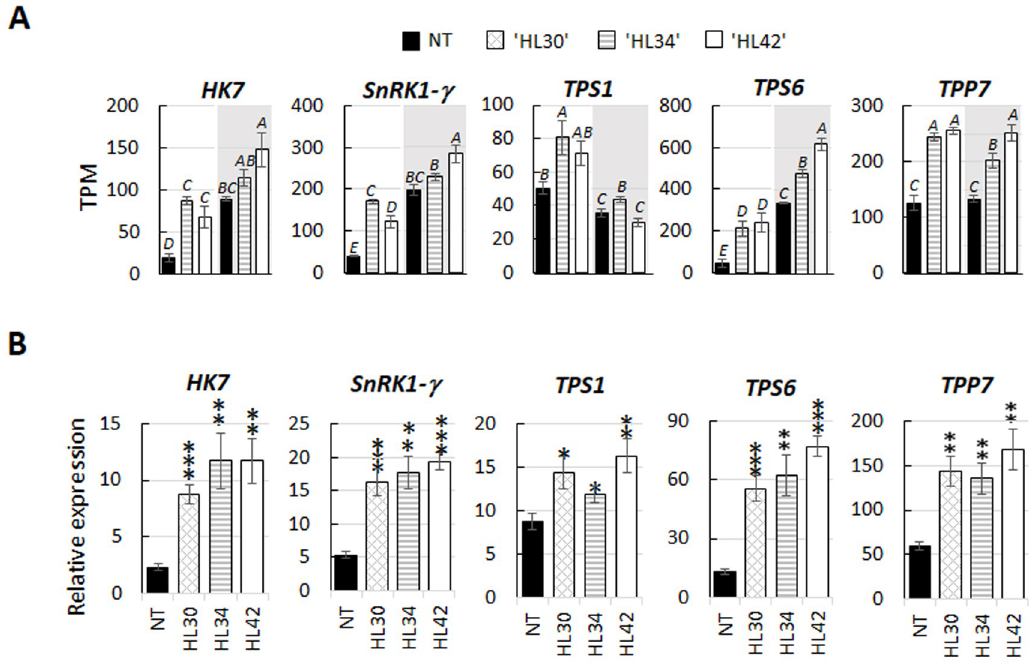
Fig 3. Expression of genes involved in sugar signalling pathway in high lipid (HL) lines. A Data represent the means of normalized transcript per million (TPM) with the error bar of the SE, identified in HL Lolium grown under standard (white graph area) and low (shading graph area) irradiance levels, compared to non-transformant (NT) control. A-E Alphabets indicated significant differences (p < 0.05, n = 3 ). B Validation of selected genes for relative expression. � indicates p < 0.05, �� for p < 0.01 and ��� for p < 0.001 (Student’s t-test). Bars represent the means and SE of five biological replicates. Gene ontology grouped in sugar signalling pathway: Hexokinase 7 ( HK7 , XP_015637554.1); sucrose-nonfermented related protein kinase 1 subunit gamma ( SnRK1 - γ , XP_015635849.1); trehalose-6-phosphate synthase 1 ( TPS1 , XP_015640390.1); trehalose 6-phosphate synthase 6 ( TPS6 , XP_015611910.1); trehalose-phosphate phosphatase 7 ( TPP7 ,